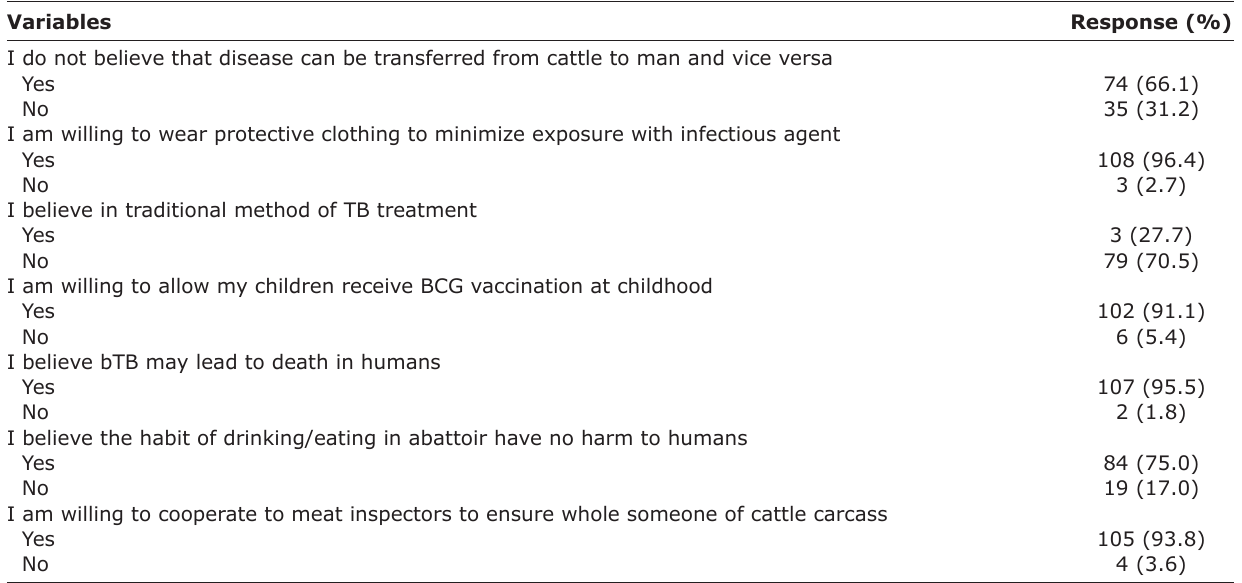
Table-4: Assessment of respondents’ attitude toward bTB in Gombe, Gombe State, Nigeria.